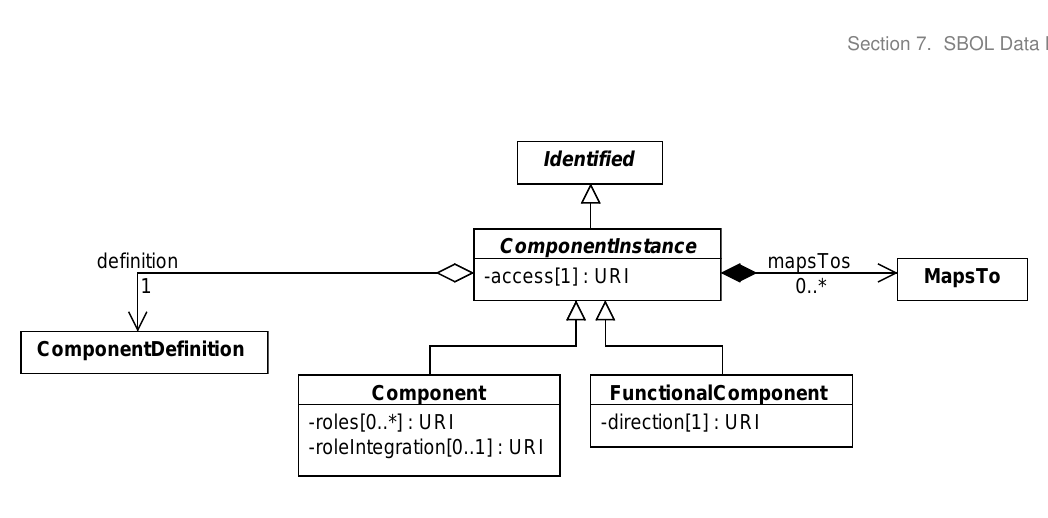
Figure 8: Diagram of the ComponentInstance class and its associated properties.